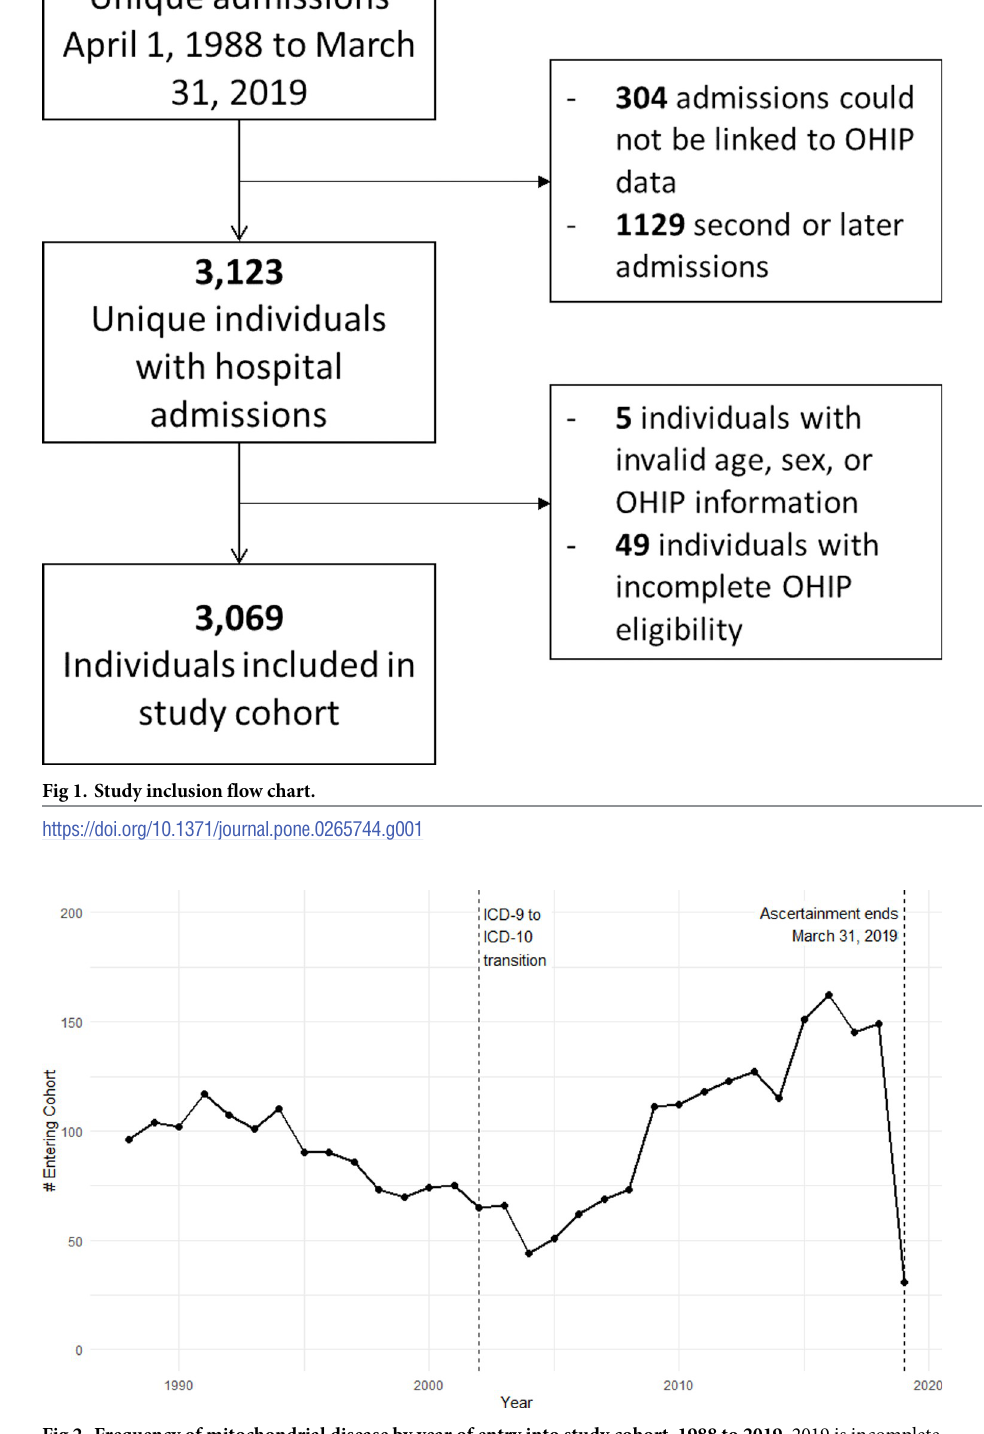
PLOS ONE | https://doi.org/10.1371/journal.pone.0265744 April 8,